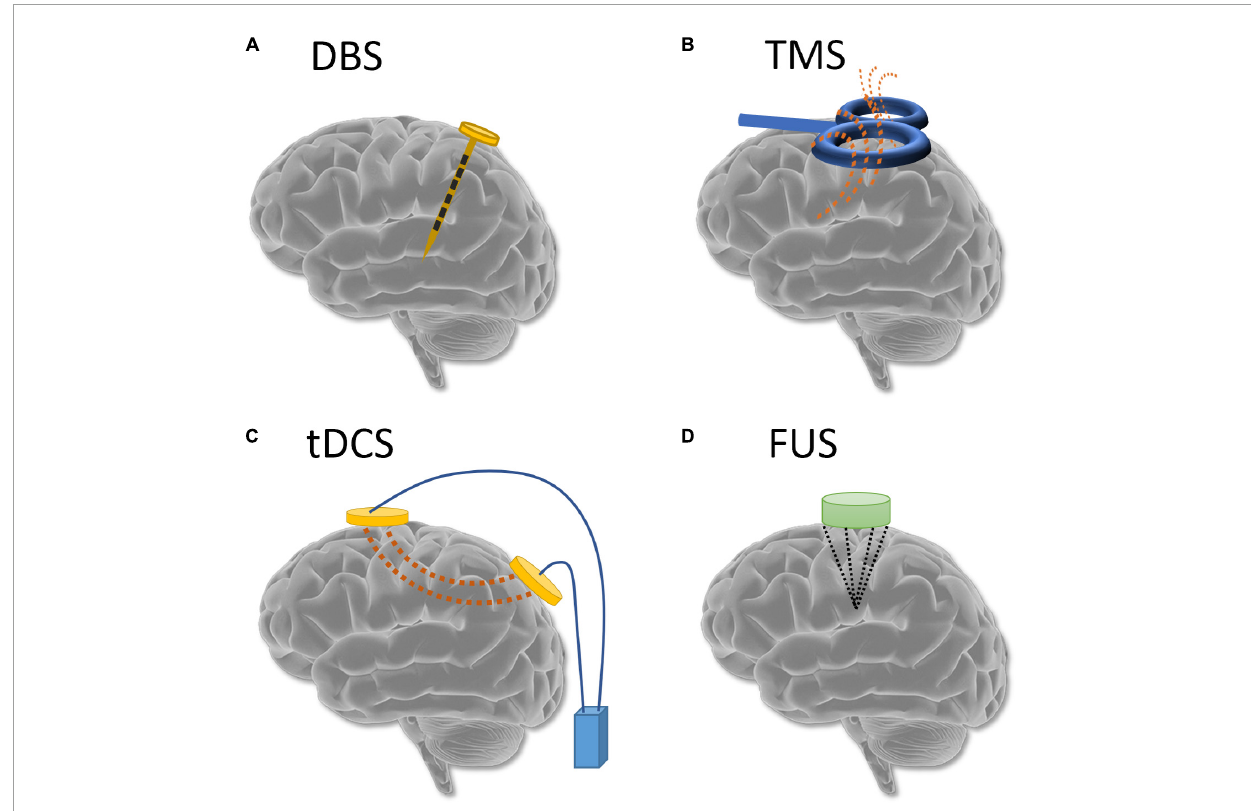
FIGURE2 Common neuromodulation techniques: (A) deep brain stimulation; (B) transcranial magnetic stimulation; (C) transcranial direct current stimulation; and (D) transcranial ultrasound